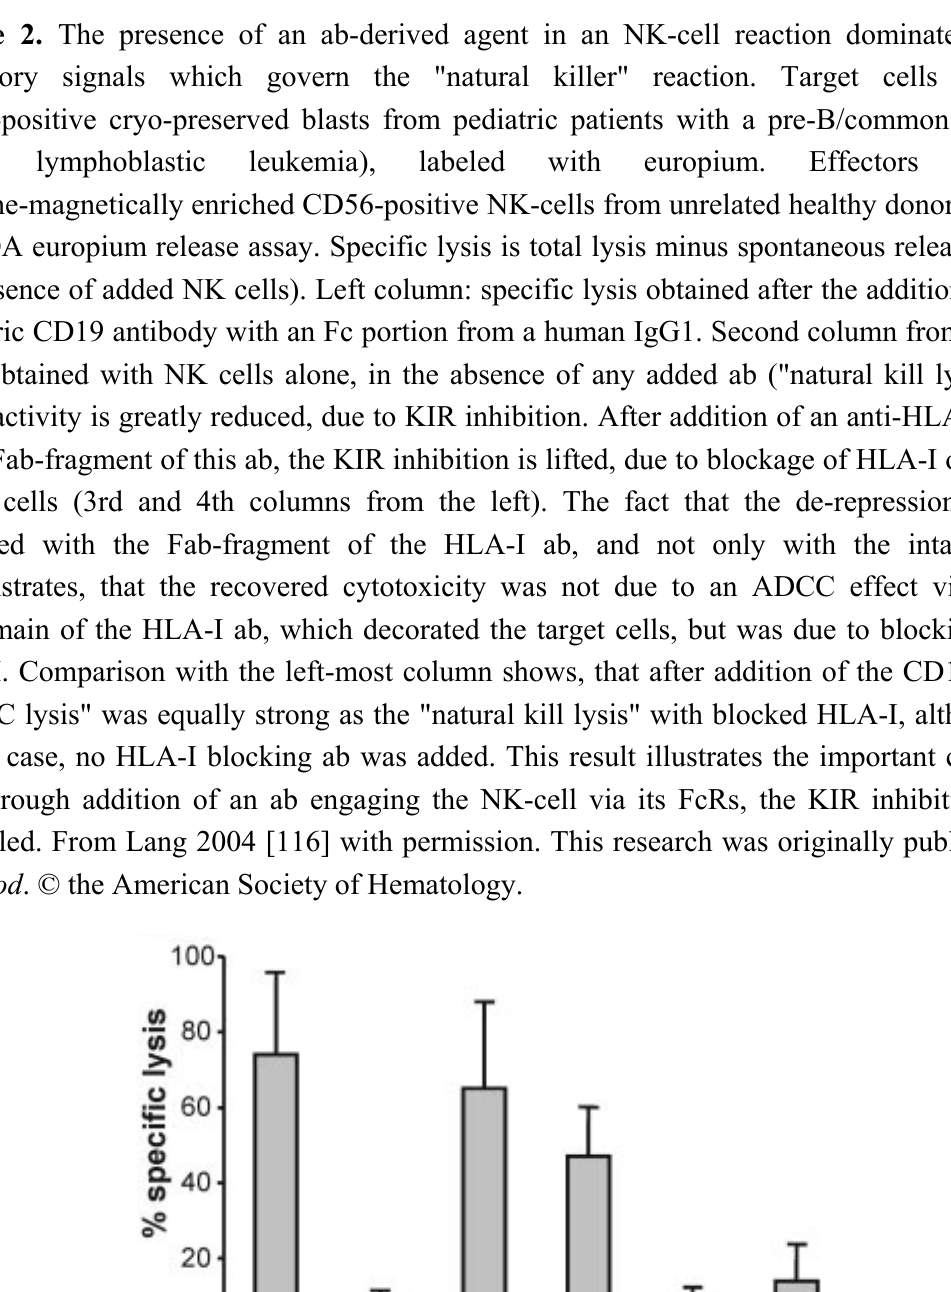
Figure 2. The presence of an ab-derived agent in an NK-cell reaction dominates the inhibitory signals which govern the "natural killer" reaction. Target cells were CD19-positive cryo-preserved blasts from pediatric patients with a pre-B/common ALL (acute lymphoblastic leukemia), labeled with europium.